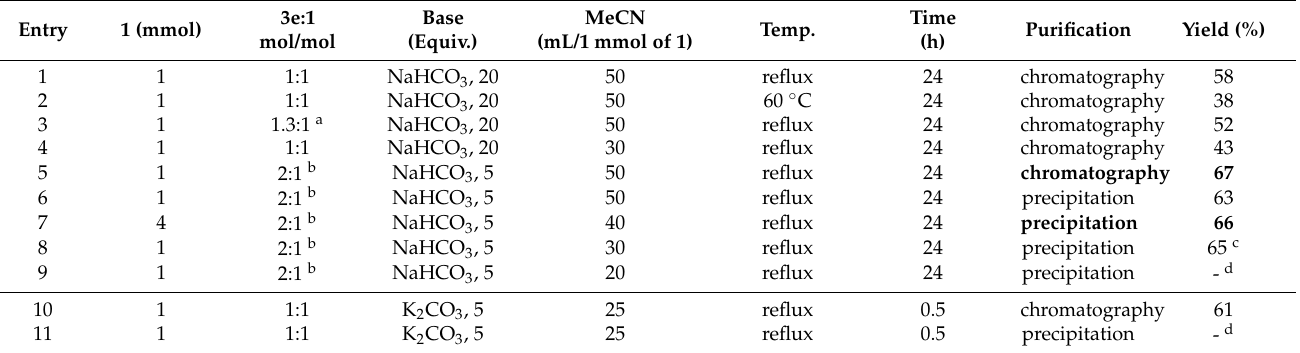
Legend: a at the beginning of the reaction 1.3 equiv. of 3e was added to the reaction flask; b at the beginning of the reaction 1 equiv. of 3e was added to the reaction flask, 0.5 equiv. of 3e was added after 17 h and 20 h; c crude compound 4e containing some by-products; d small amount of contaminated product 4e